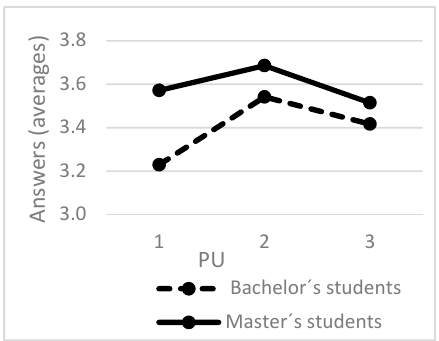
Figure 1. Answers of undergraduate and graduate students in PU (average values).